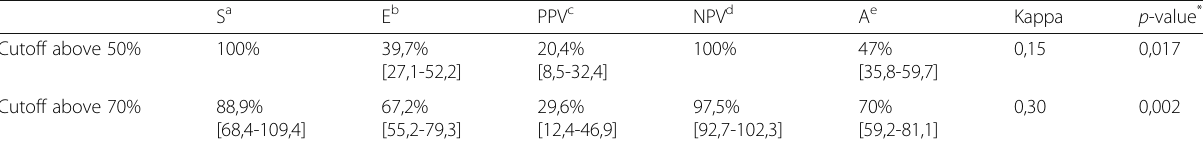
Table 2 Concordance between the immunohistochemical test for translocation involving the BCL2 gene, with FISH as gold standard: comparison between 50% cut-off and 70% cut-off for definition of immunopositivity for BCL2 in immunohistochemistry